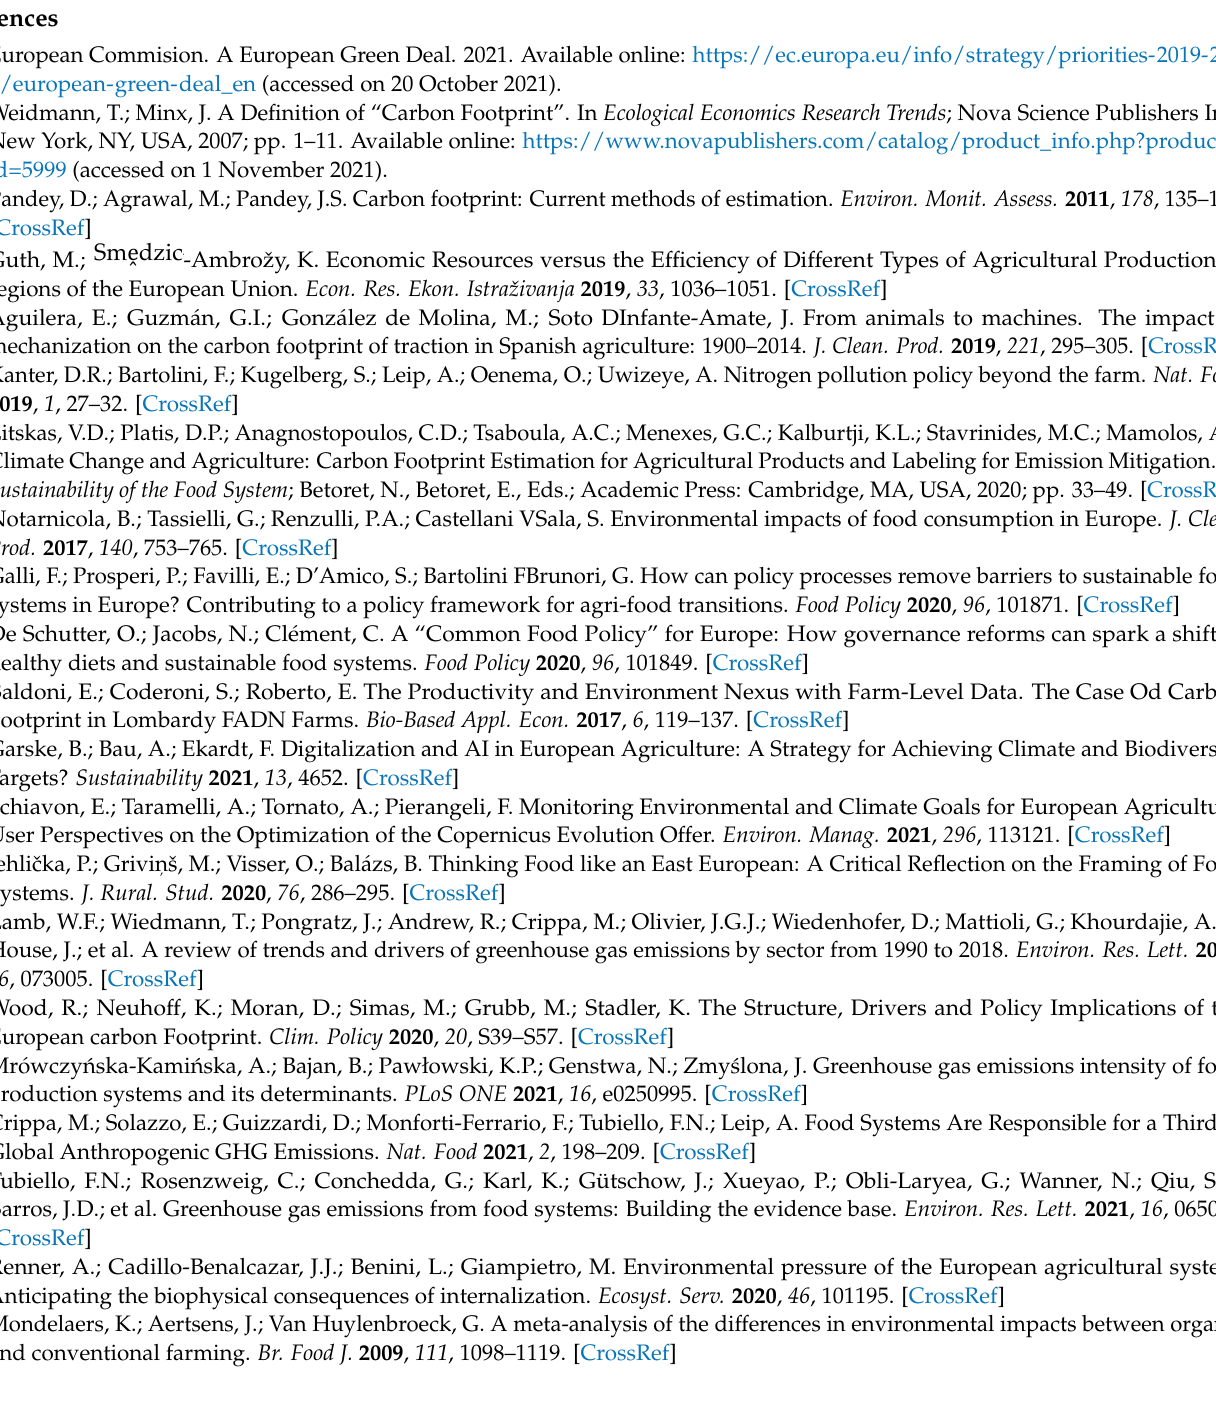
Table 3. The variable’s influence on the pollution reduction in temporary